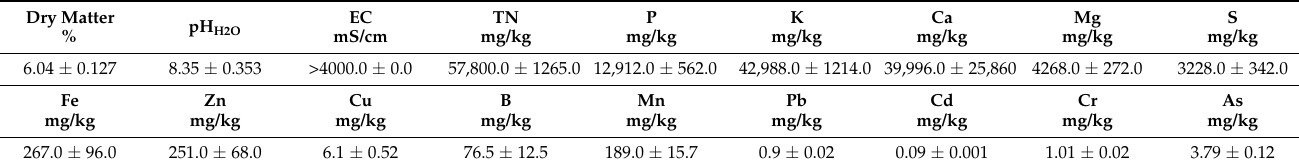
Table 11. Quality composition of liquid phase of digest for hemp fertilization